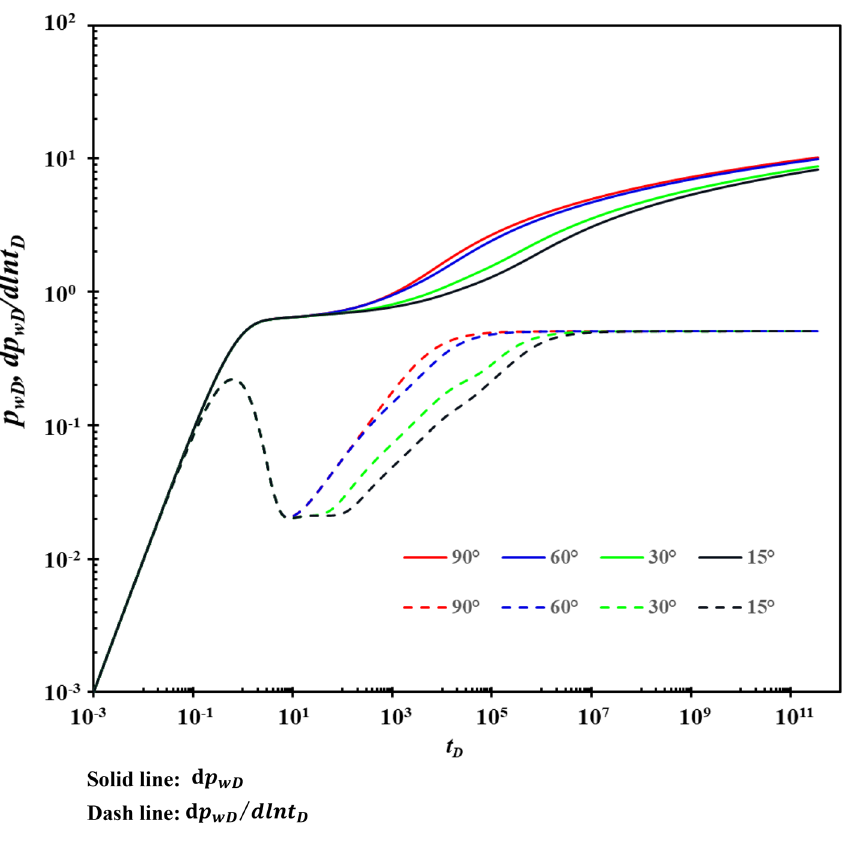
Figure 15. The effect of the fracture direction on type curves.